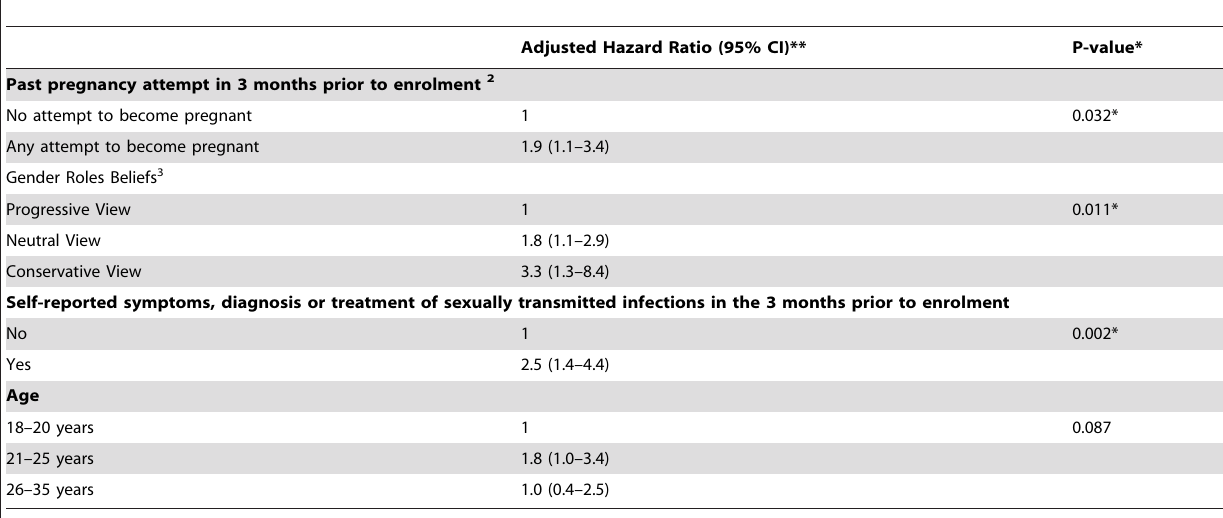
Table 2. Multivariable model of the association of past pregnancy attempts, gender roles beliefs, STI symptoms and age with pregnancy incidence (n=409; 54 pregnancies) 1